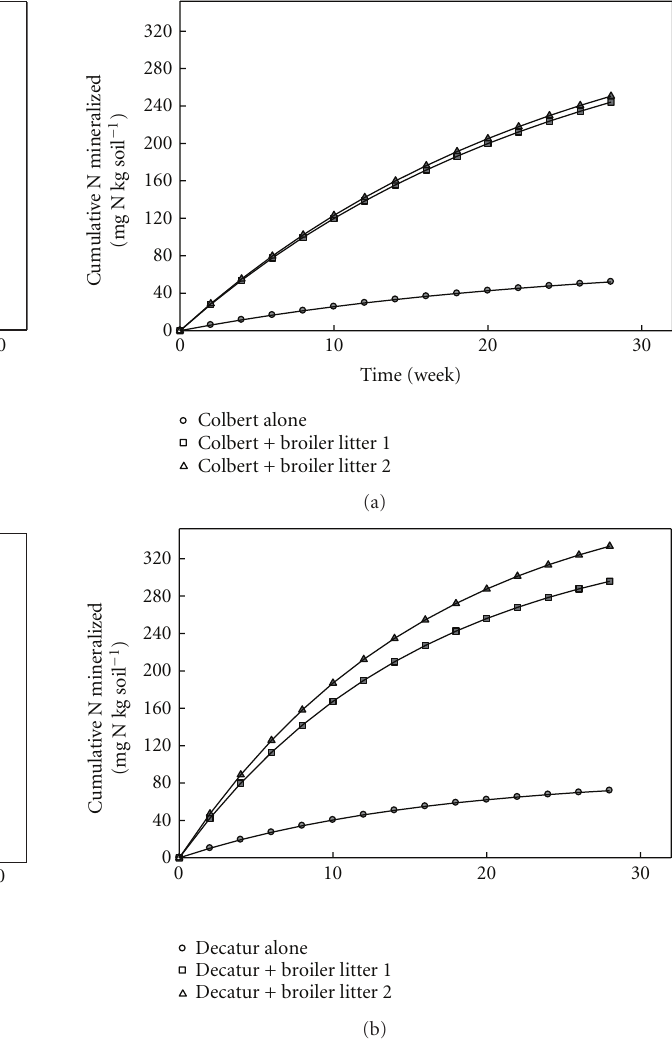
Figure 2: Cumulative organic nitrogen mineralized from Colbert (a) or Decatur (b) soils amended with broiler litter 1 or 2 and incubated for 28 weeks under aerobic